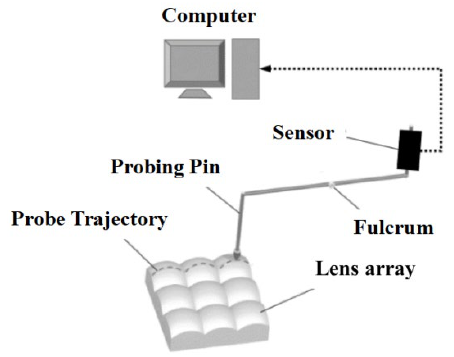
Figure 1. Contact detection principle diagram.